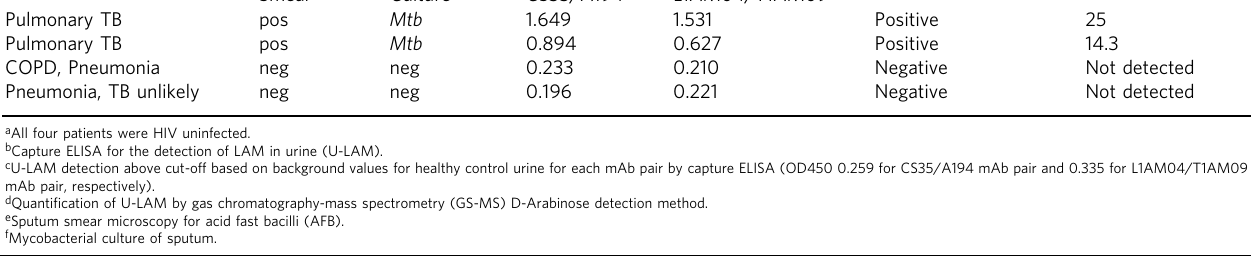
Table 2 Capture and detection of LAM from the urine of subjects with pulmonary TB by Sandwich ELISA. Diagnosis a